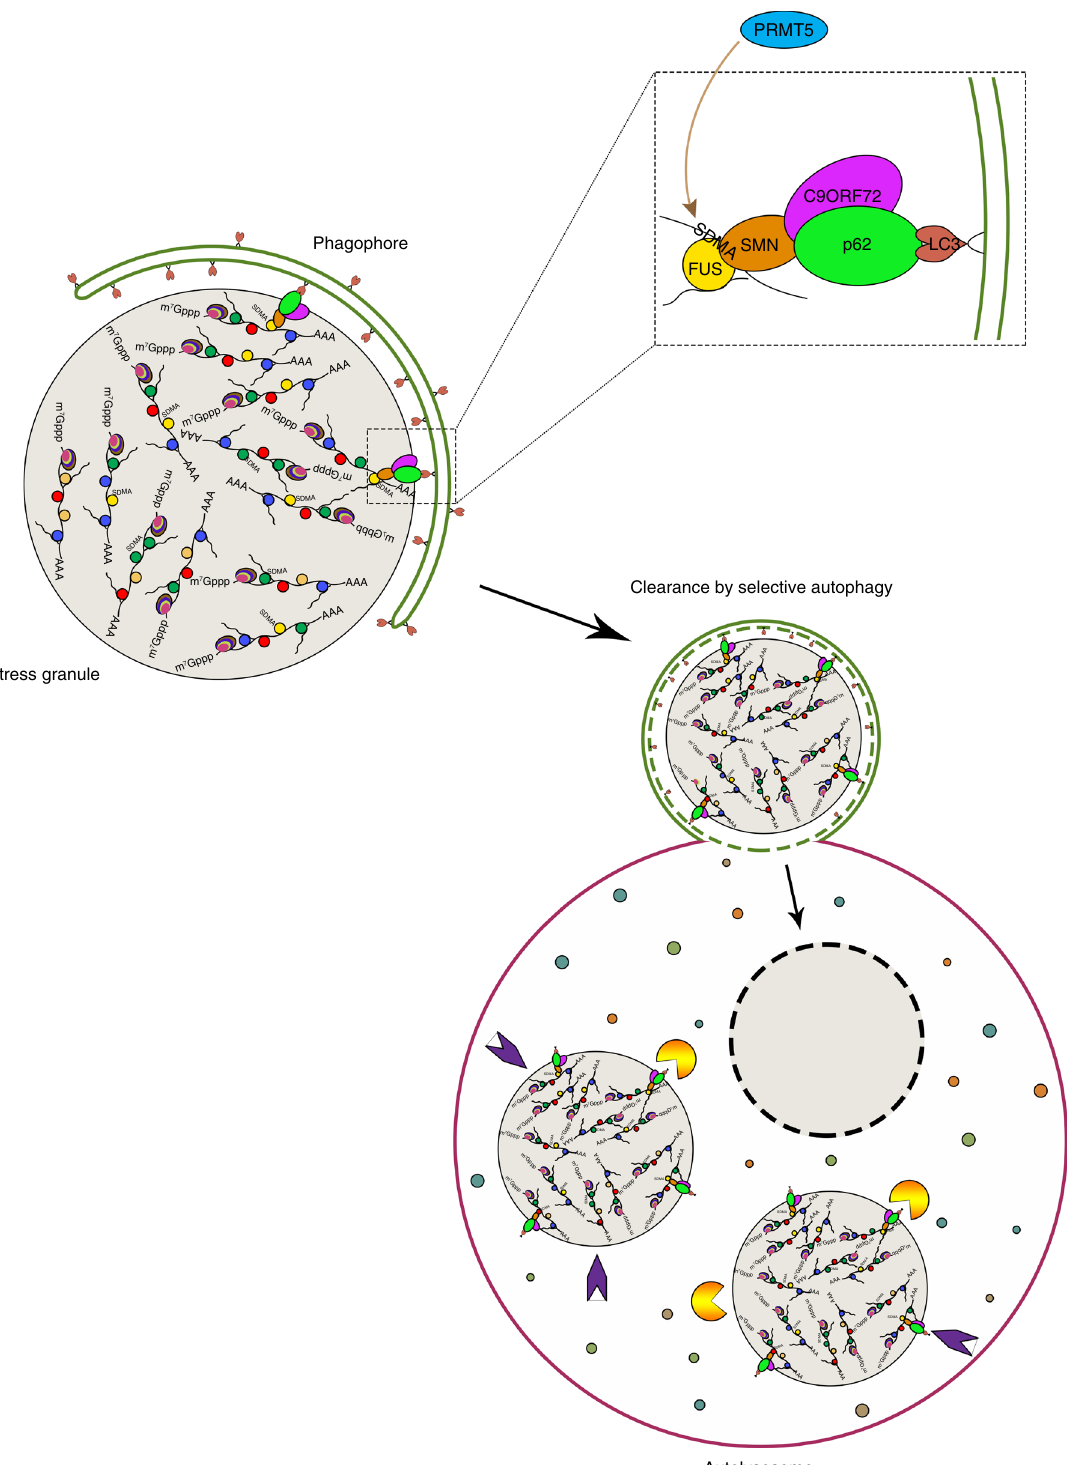
Fig. 7 Model . Stress granule proteins such as FUS are symmetrically dimethylated on arginines by PRMT5 to bind Tudor-domain containing protein SMN for subsequent recruitment and degradation by p62-C9ORF72 mediated selective autophagy min. At least 100 cells were counted per experiment for quanti fi cation of cells harvested for analyses 48h post transfection. siRNAs and plasmids used in the containing stress granules. HeLa and MN-1 cells were treated with Ba fi lomycin study are listed in Supplementary Tables 9, 10. A1 (196000, EMN Millipore) for 16 h at 400 nM. HeLa cells were treated with (i) For all stress granule experiments, HeLa and MDA-MB-231 cells were Chloroquine (sc-205629A, Santa Cruz Biotechnology) for 16 h at 20 μ M, (ii) induced with 0.5 mM sodium arsenite (71287, Sigma-Aldrich) for 30 min MTA (Sigma-Aldrich) for 48 h at 1 mM, (iii) PRMT5 inhibitor — EPZ015666 followed by a PBS wash and recovery in complete DMEM up to 1 h. Primary (SML1421, Sigma-Aldrich) for 48 h at 3 μ M, and (iv) Ubiquitin E1 inhibitor — cultures of mixed motor neurons were induced with 0.5 mM sodium arsenite PYR-41 (N2915, Sigma-Aldrich) for 3 h at 50 μ M. (71287, Sigma-Aldrich) for 1 h followed by a PBS wash and recovery up to 30 NATURE COMMUNICATIONS| (2018) 9:2794 |DOI: